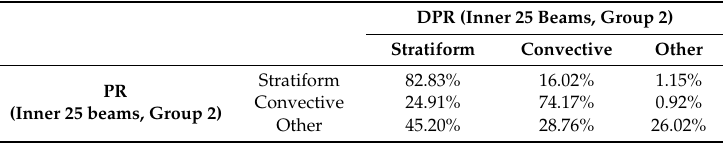
Table 6. The number of matchup pixels in Group 2 (the inner 25 beams) between TRMM PR and GPM DPR, categorized according to precipitation types determined by two datasets. The numbers in parentheses are frequencies relative to the total for each TRMM PR precipitation type